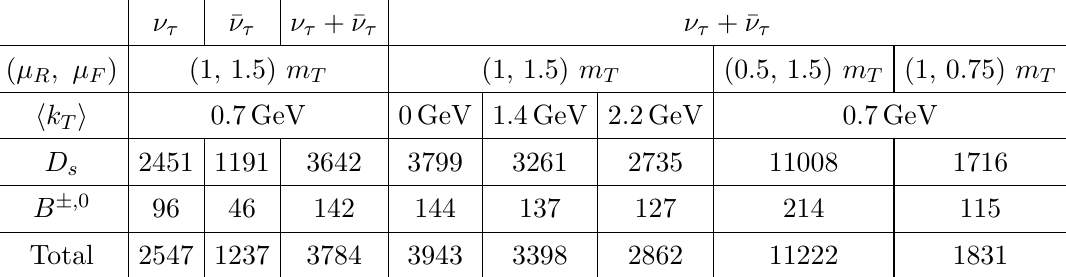
p s = 14 TeV and an integrated